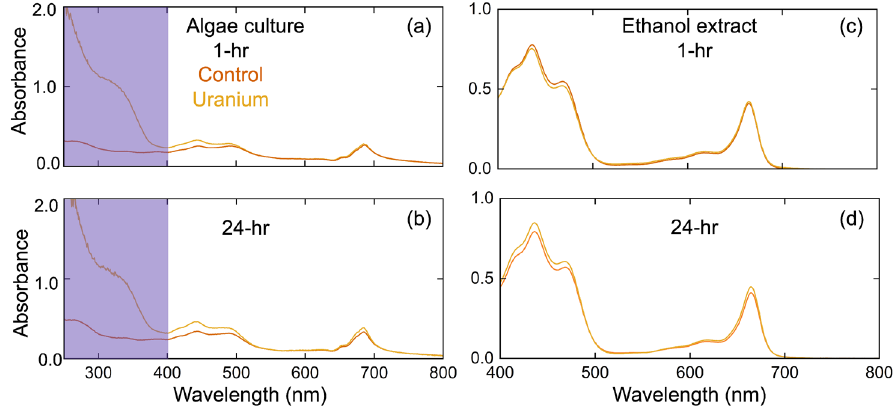
Figure 4. Representative absorbance spectra for the control and U-stressed algae at ( a ) 1-h and ( b ) 24-h exposure in growth media and the pigment extract in 95% ethanol for ( c ) 1-h and ( d ) 24-h. The spectrometer is zeroed to a cuvette containing water for ( a , b ), and to a cuvette containing 95% ethanol for ( c , d ).